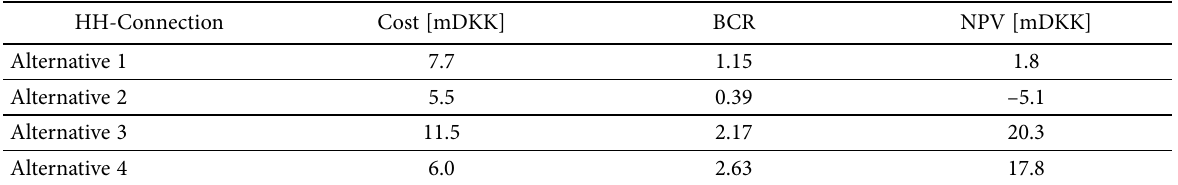
Table 3. Results from the initial deterministic run of the UNITE-DSS model (based upon data material from Larsen, Skougaard 2010)